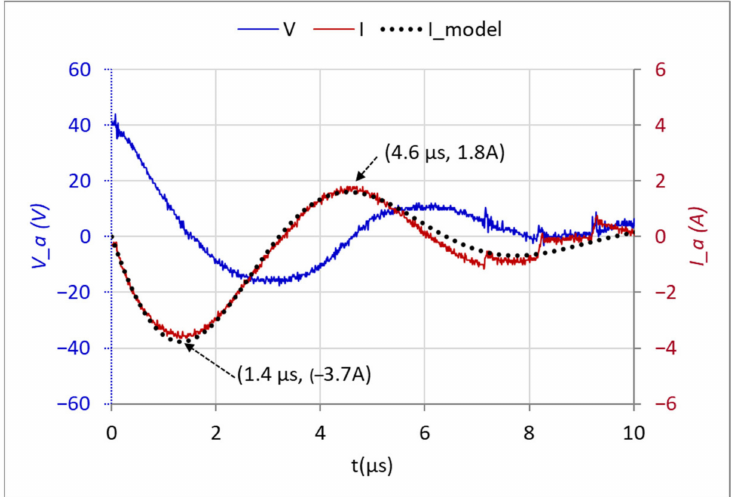
Figure 5. Fast discharging of the multilayer actuator is according to natural response of an RLC